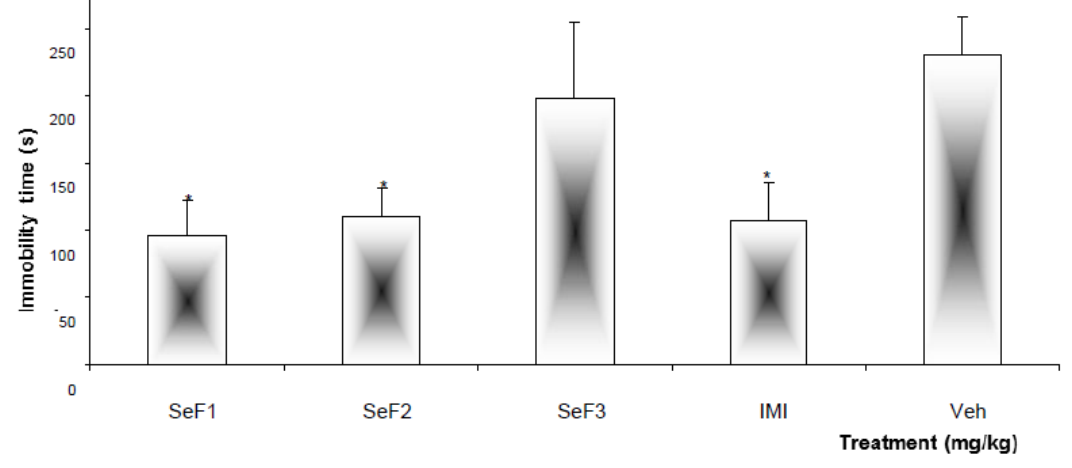
Figure 2. Effect produced by different sub-fractions, SeF1, SeF2, and SeF3 (orally, 250 mg/kg) obtained from Salvia elegans , as well as imipramine (IMI, 15 mg/kg, intraperitoneally [i.p.]) and the vehicle (Veh, 1.0% Tween [TW] 20) administered to